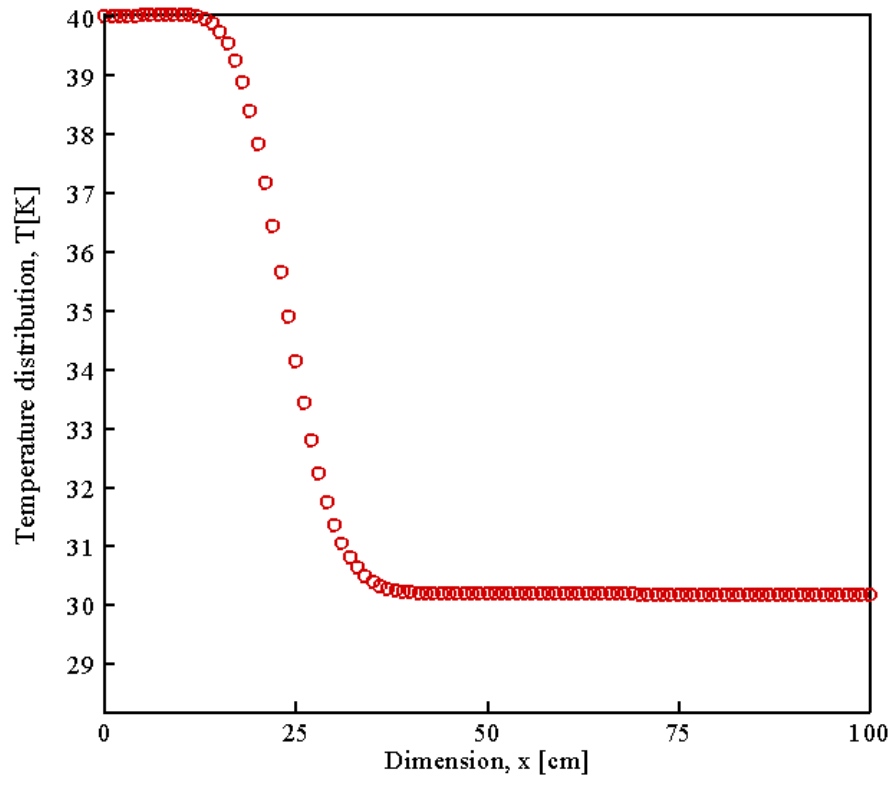
x at the different thermobaric condi-